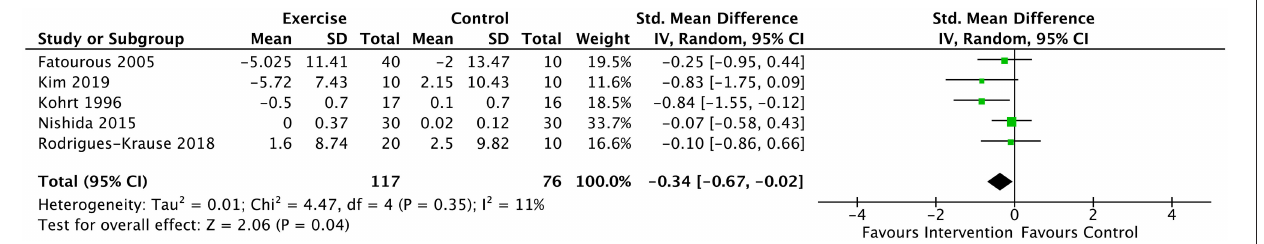
FIGURE 2 | Forest plot for the effect of exercise on glucose. Results favor lower scores in experimental group. Model is statistically significant with low heterogeneity ( I 2 = 11%), suggesting reliability of the small effect size ( − 0.34).